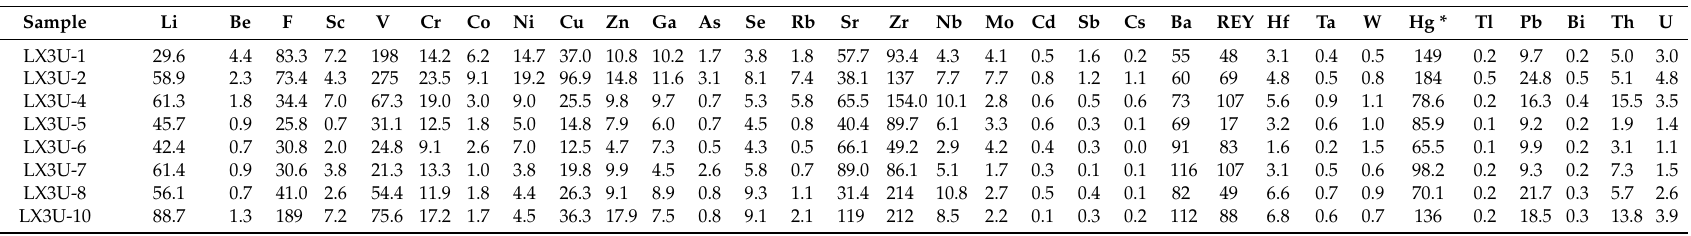
Table 4. Concentrations of trace elements in the Upper No. 3 coals from the Luxi, Liangbaosi, and Tangkou mines, southwestern Shandong, China ( µ g/g unless otherwise